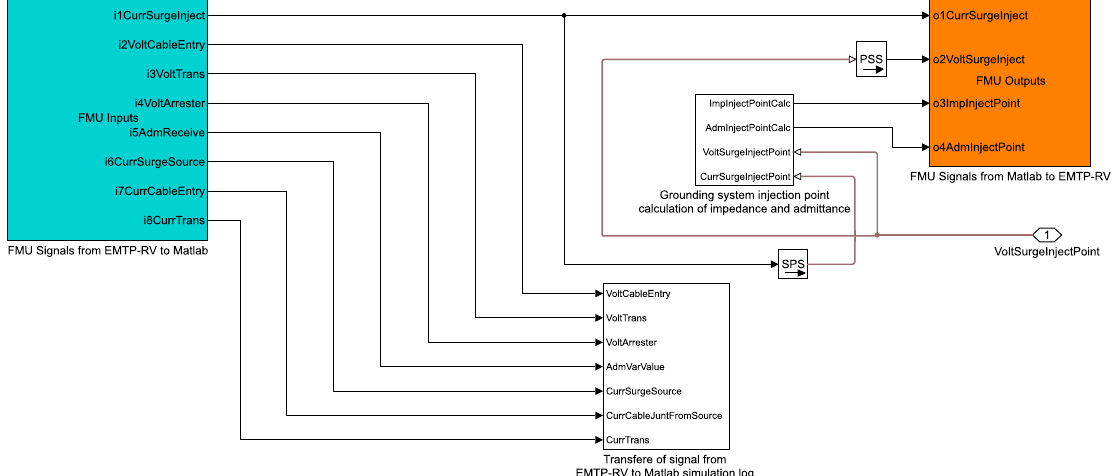
Figure A1. The Matlab/Simulink FMI interface to EMTP-RV with the signals transferred between the softwares and block representation of the integration.